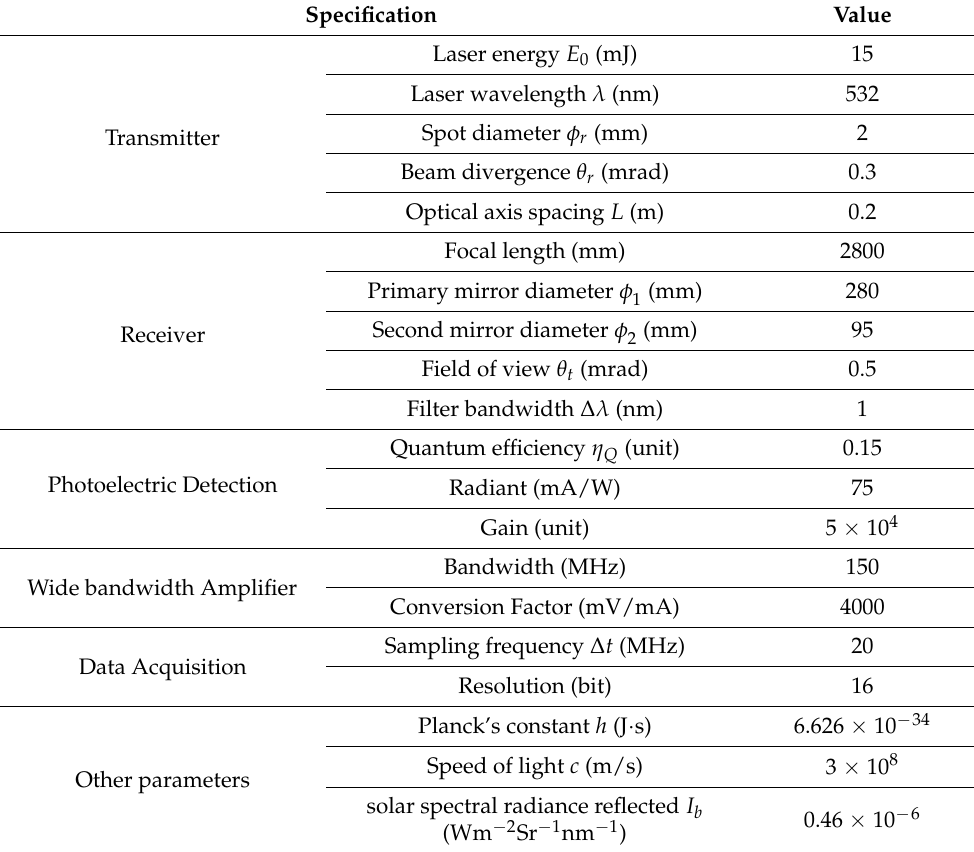
Table A2. The simulation parameter information of